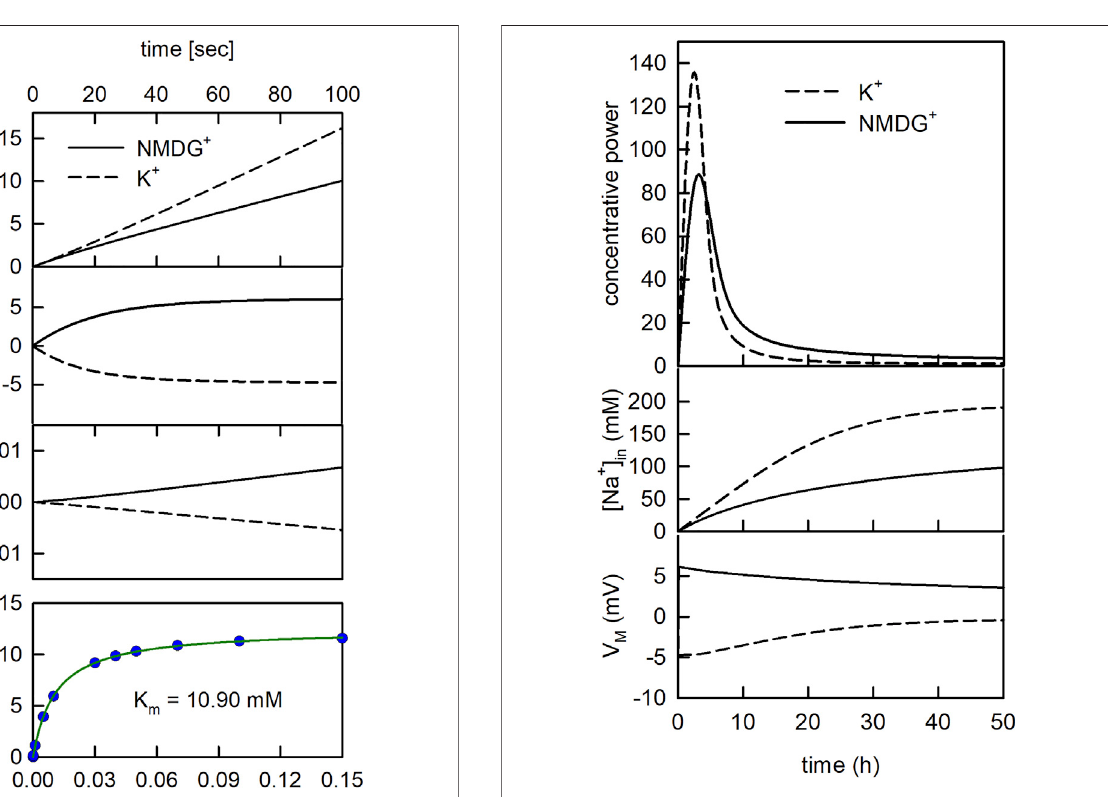
dependent change in vesicular volume in percent. We also simulated glucose uptake as a function of the extra-vesicular glucose concentration (lower panel of Figure 4 ). These data V max values for glucose uptake estimated by the fi t were 10.90 mM and 1.22 ± 0.006 10 − 23 mol/s, respectively. of SGLT1 (i.e., [Glu] in /[Glu] out ) as a function of time in the assumed presence (dashed line) and absence (solid line) of a K + gradient. In the simulation we applied 1 µM glucose to the